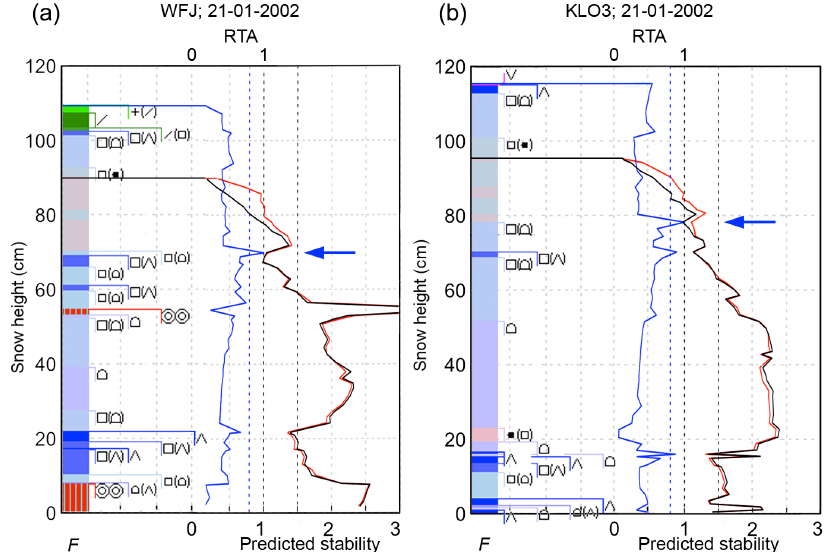
Figure 10. Simulated snow profiles for (a) Weissfluhjoch and (b) Gatschiefer. Grain shape (F) is shown using the symbols and the colours according to the international snow classification (Fierz et al., 2009). The blue solid line is the RTA (Monti et al., 2014a) and was used to detect potential weak layers from a structural point of view (values higher than the blue dashed line). The blue arrow highlights the potential weak layer depth. Black solid line is the SK 38 index while the red solid line represents the refined SK ML 38